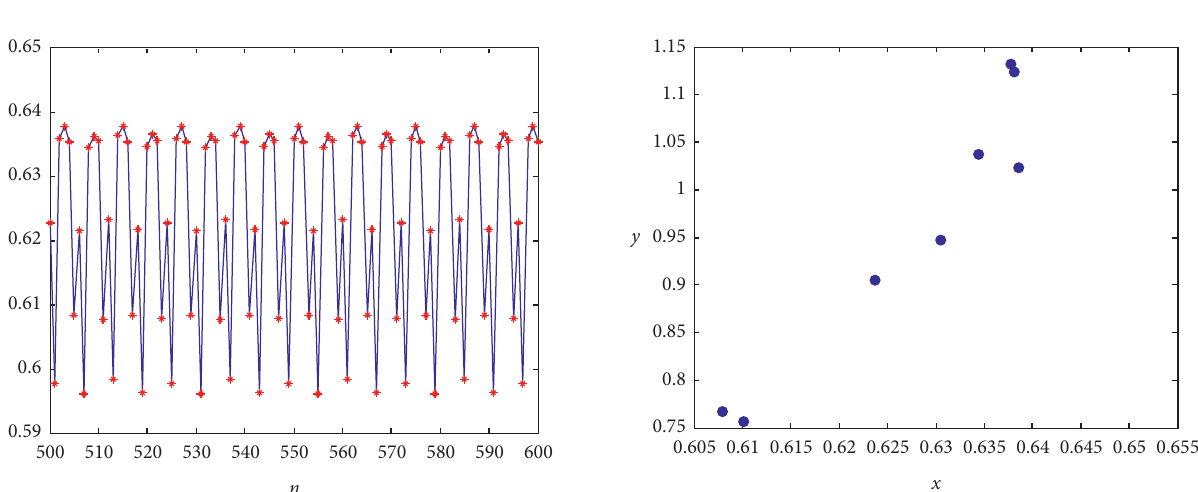
Figure 23: x - n sequence diagram which denotes that the system is periodic when c � 0.39.